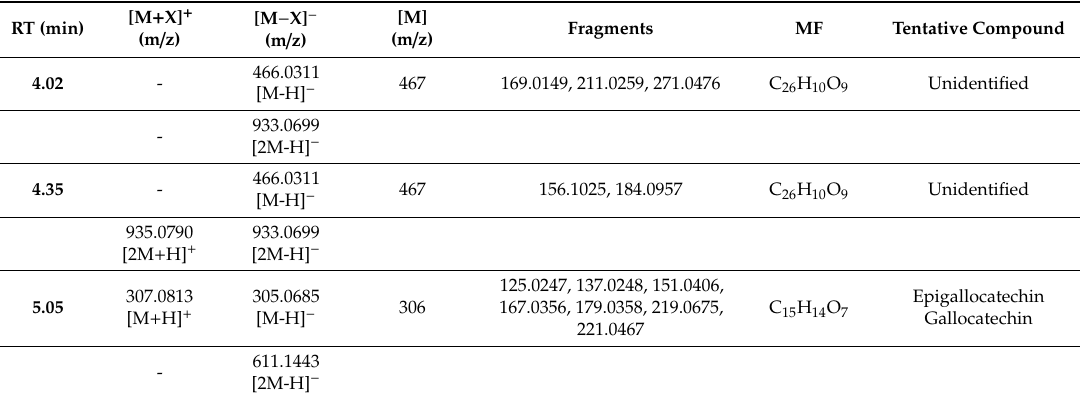
Figure 2. Total ion chromatogram (TIC) for arrayan. TIC of arrayan extract is shown in negative and positive modes. Table 6. Identification of compounds from arrayan fruits by liquid chromatography coupled with mass spectrometry (LC-MS) and MS/MS data. The principal peaks were individually analyzed, and the potential compounds were analyzed. RT, retention time; MF, molecular formula.